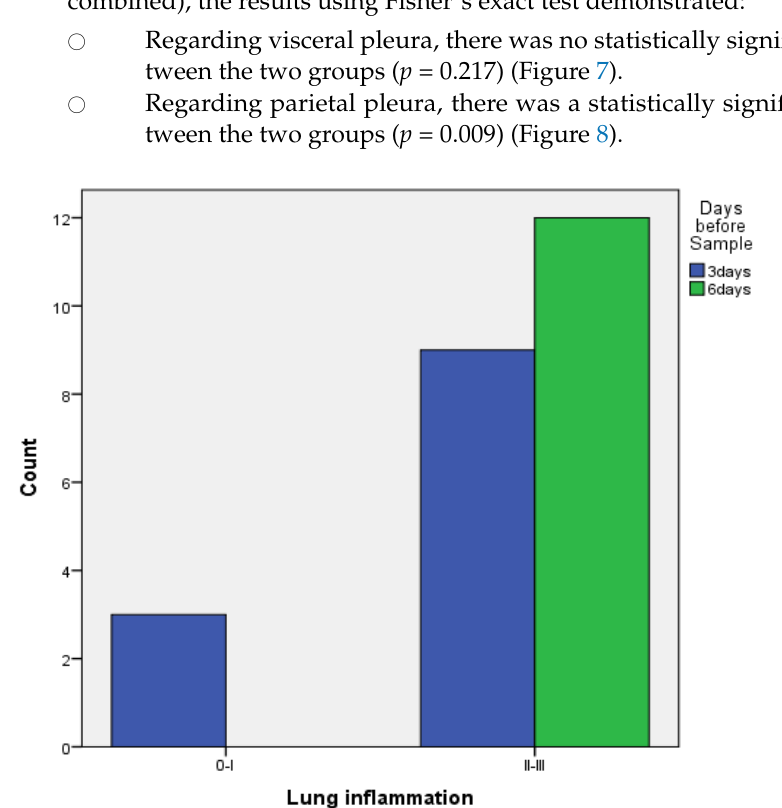
Figure 7. Visceral pleura inflammation at 3 vs. 6 days of PRP and talc combined.